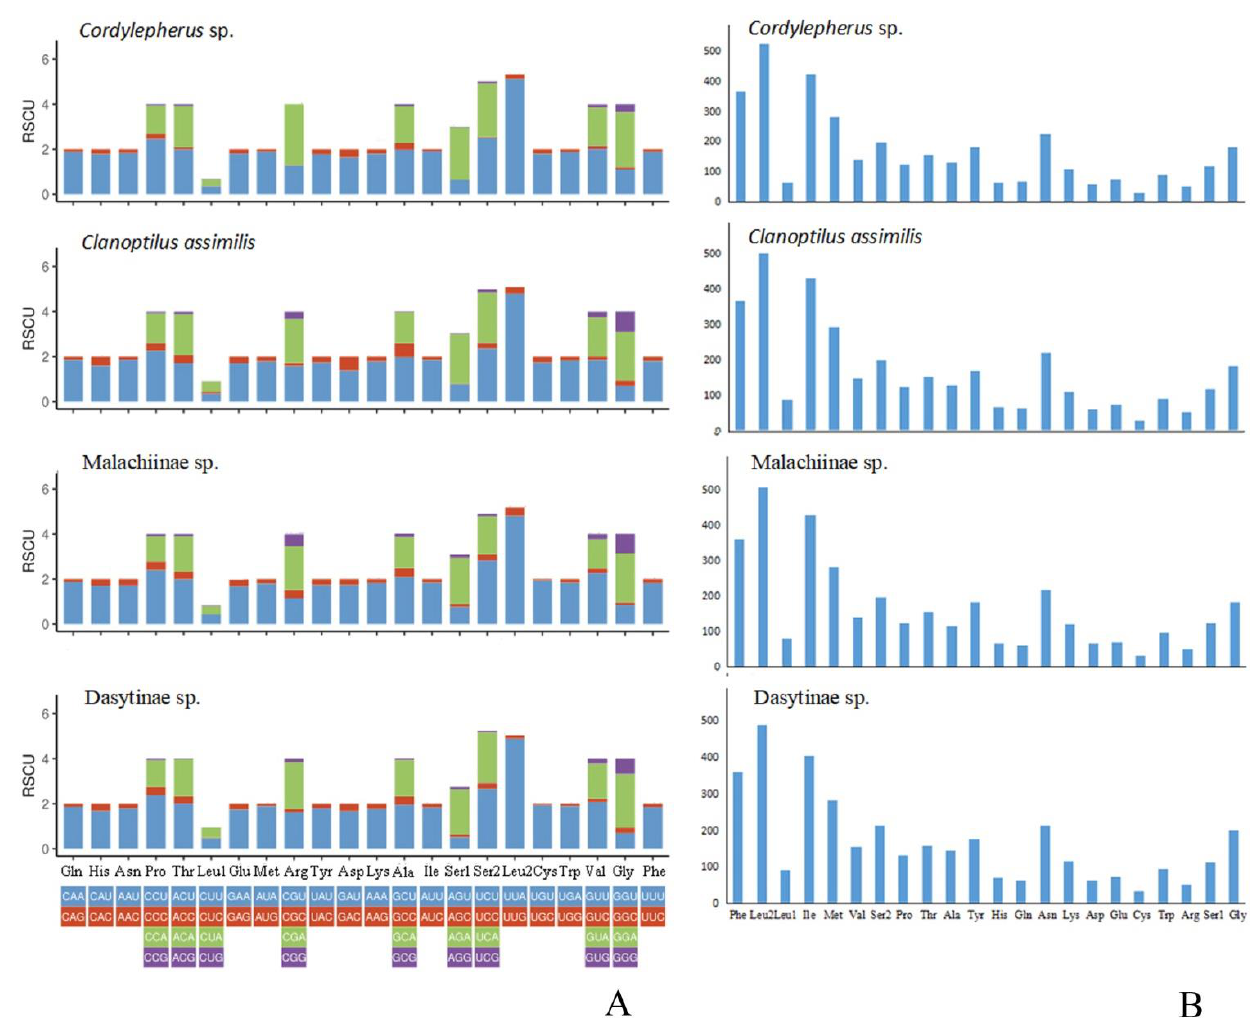
Figure 2. ( A ) Relative synonymous codon usage (RSCU) in the Melyridae species’ mitogenomes; ( B ) amino acid composition in the Melyridae species’ mitogenomes.